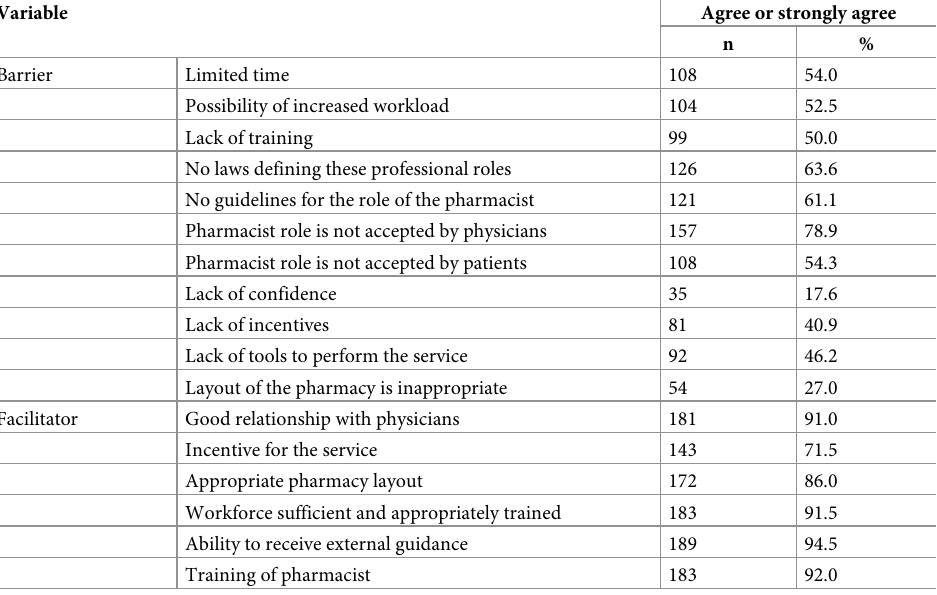
Table 5. Barriers and facilitators identified for provision of DRP-reduction services among community pharma- cists (N = 200).